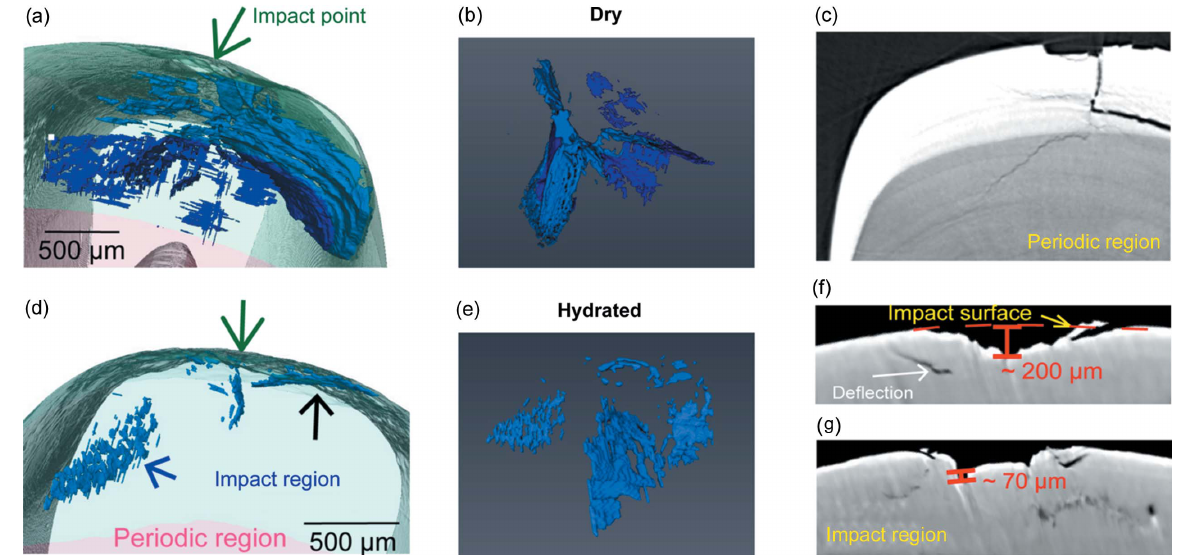
Figure 3 Influence of hydration state on the structural response of dactyl club subjected to impact. ( a ) 3D distribution of main crack systems within ‘dry’ dactyl club. ( b ) Crack system with a different perspective to ( a ). The isolated crack systems indicate that the crack nucleated at multiple sites. A major crack system was formed under the loading point and propagated into the periodic region, which can be easily spotted from the representative slice ( c ) of the 3D reconstruction results. A zigzag-shaped crack path can be identified in the periodic region showing a characteristic crack deflection phenomenon found in this region. ( d )–( e ) 3D distribution of the main crack systems within the ‘hydrated’ dactyl club. In contrast, no major cracks developed right under the loading point but several separate cracks formed around the loading point. The main cracks propagated to the interface of the impact surface and impact region and are then significantly deflected, which can also be easily spotted from representative slices ( f )–( g ) of 3D